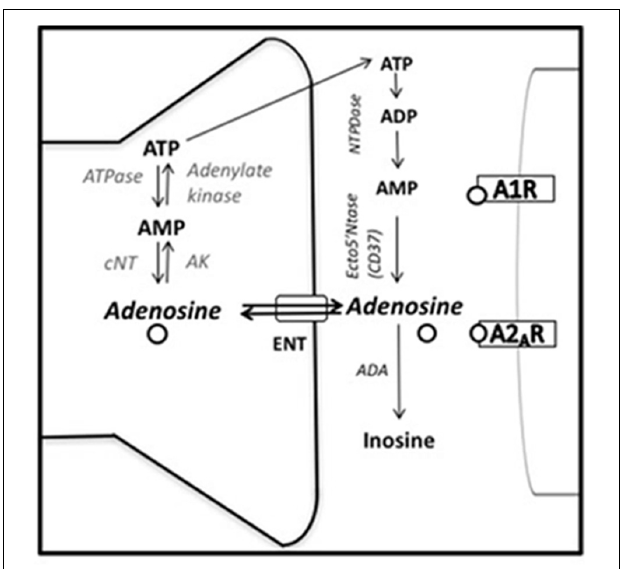
FIGURE 2 | Adenosine synthesis and metabolism. ADA, adenosine deaminase; AK, adenosine kinase; A 1 R and A 2A R, adenosine A 1 and A 2A receptors; cNT, cytosolic endo-nucleotidase; ENT, equilibrative nucleoside transporter; Ecto5 (cid:48) Ntase (CD73), 5 (cid:48) -ectonucleotidase; NTPDase, nucleoside triphosphate dephosphorylase (adapted from Ruby et al.,